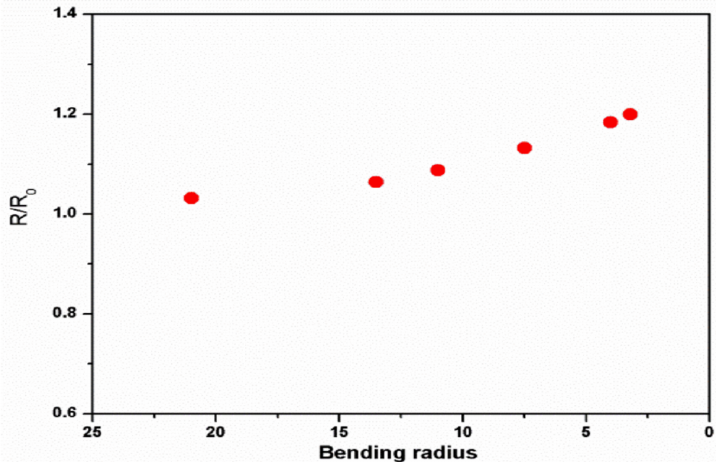
Figure 12. Variations in resistance as a function of bending-radius for the graphene aerogel/PDMS composites. Reproduced with permission from [116].